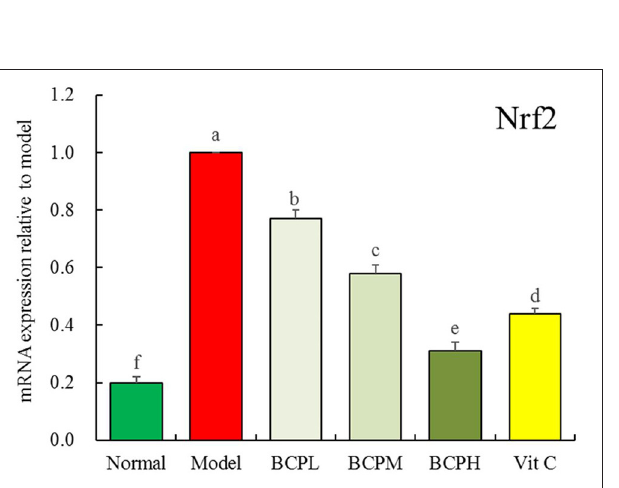
FIGURE 8 | Effect of BCP on mRNA expressions of Nrf2 of H9c2 cell nucleus with OS injury. a − f Mean values with different letters over the bar are significantly different ( P < 0.05) according to Tukey’s honestly significant